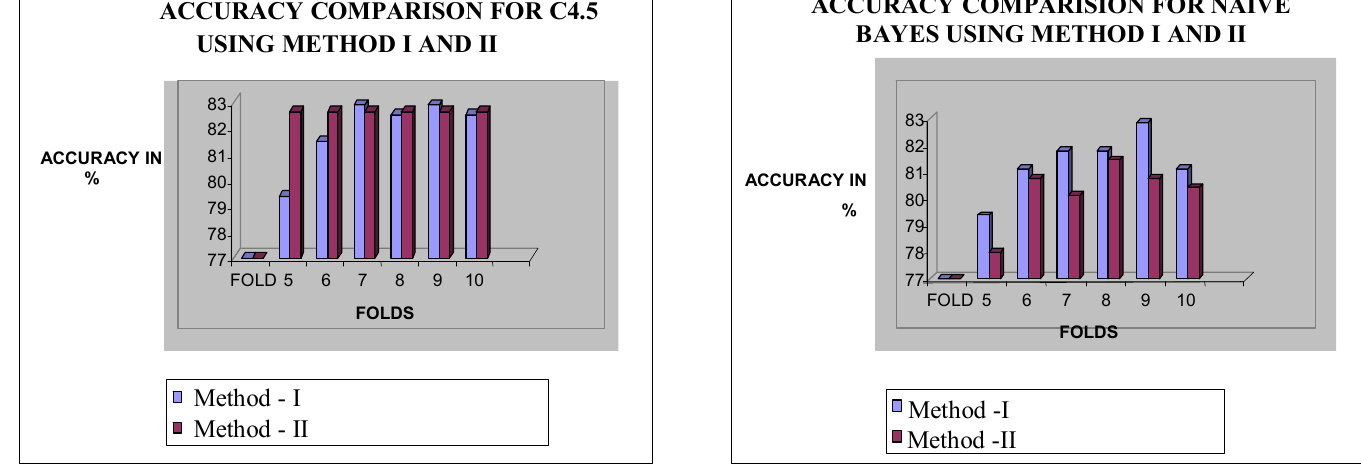
Graph 2: Accuracy Comparison for C4.5 using method Graph 3: Accuracy Comparison using method I